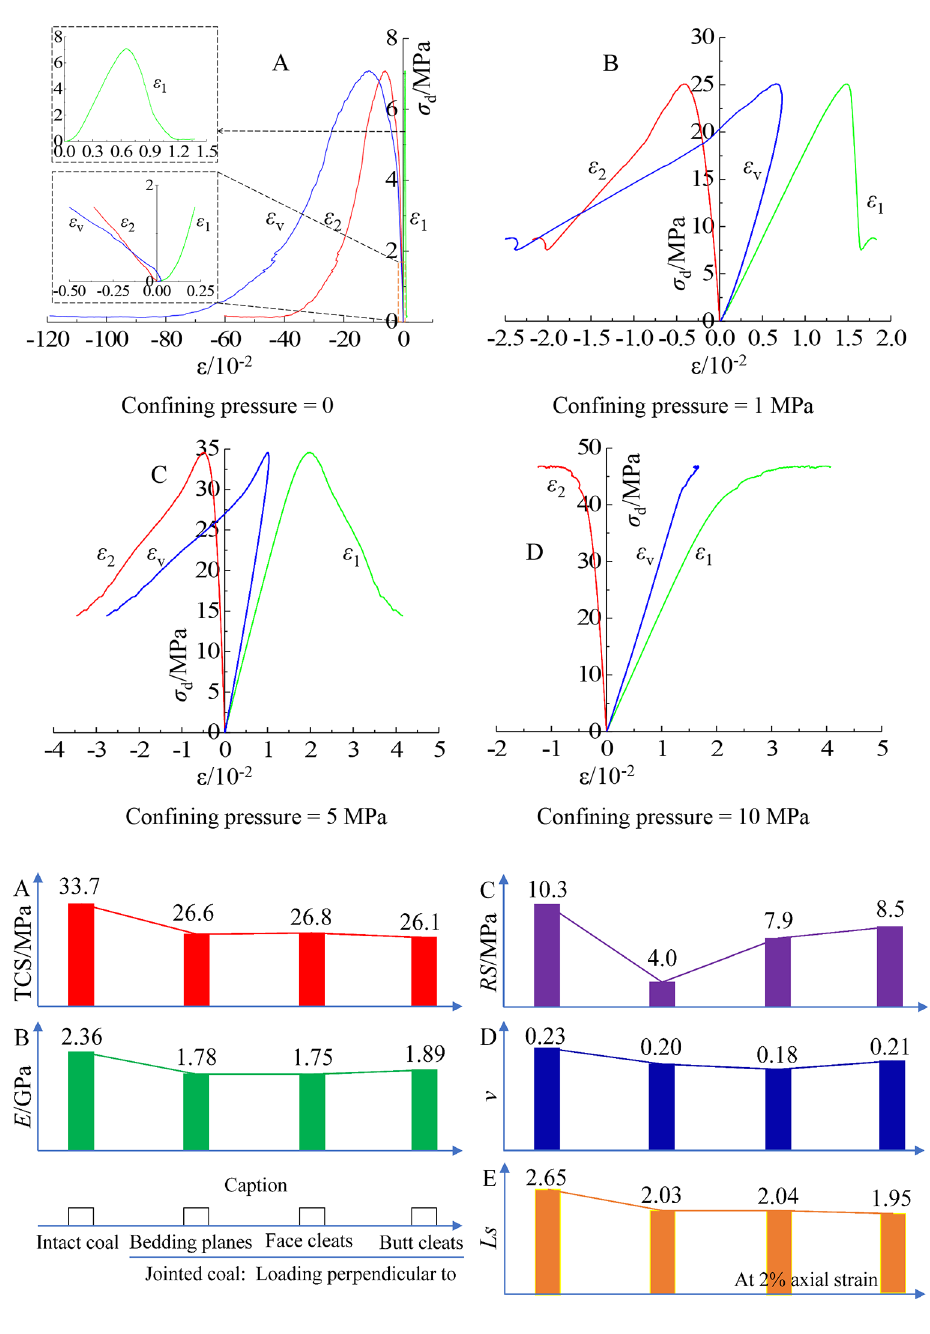
Table 3 Strength comparison between intact coal and jointed coal with and without 1 MPa confining pressure Confining pressure (MPa) Differ -